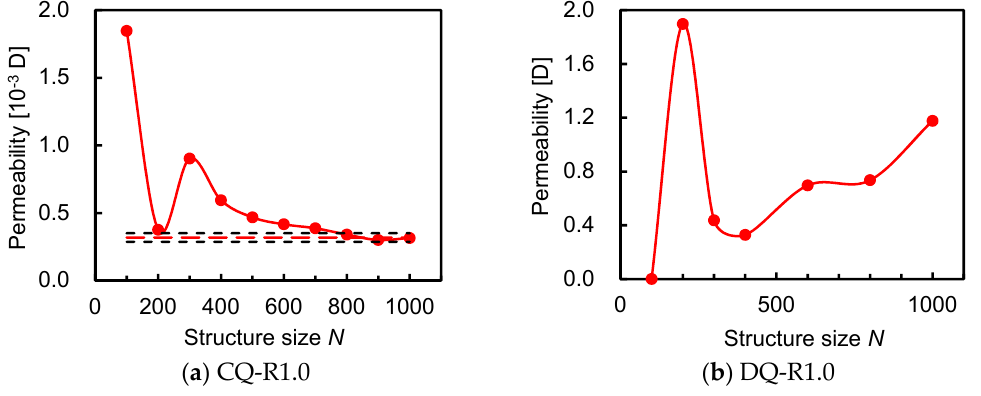
Figure 10. Sample size effect on calculated permeability at (cid:1844) = 1.0 resolution.